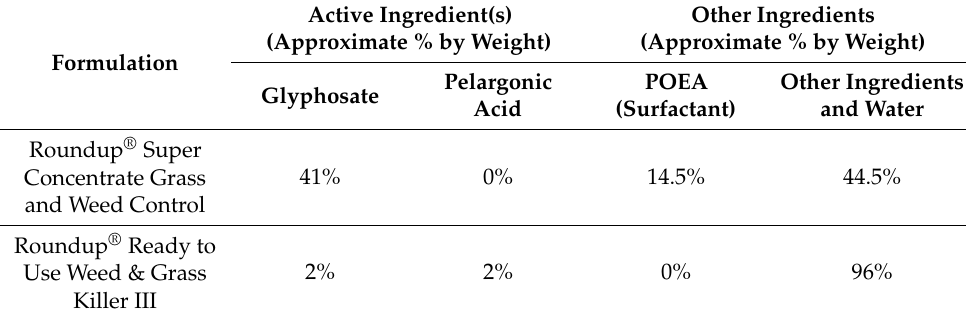
Table 1. Composition of the Roundup ® formulations used in this study. Formulation